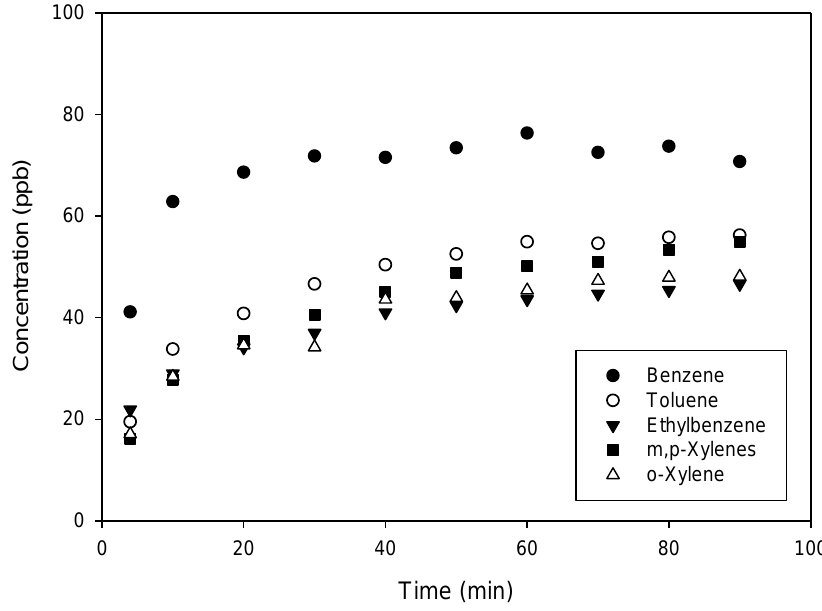
Figure 5. BTEX concentration time profiles were obtained without any micromixer by generating a targeted gas mixture of 50 ppb from a gas cylinder of BTEX at 1000 ppb of each compound. Other parameters were fixed at: Q = 25 NmL min −1 ; P pol = 200 mbar; t carrier = 1 s. For m,p-Xylenes, the concentration reported corresponds to the individual concentration of each compound.